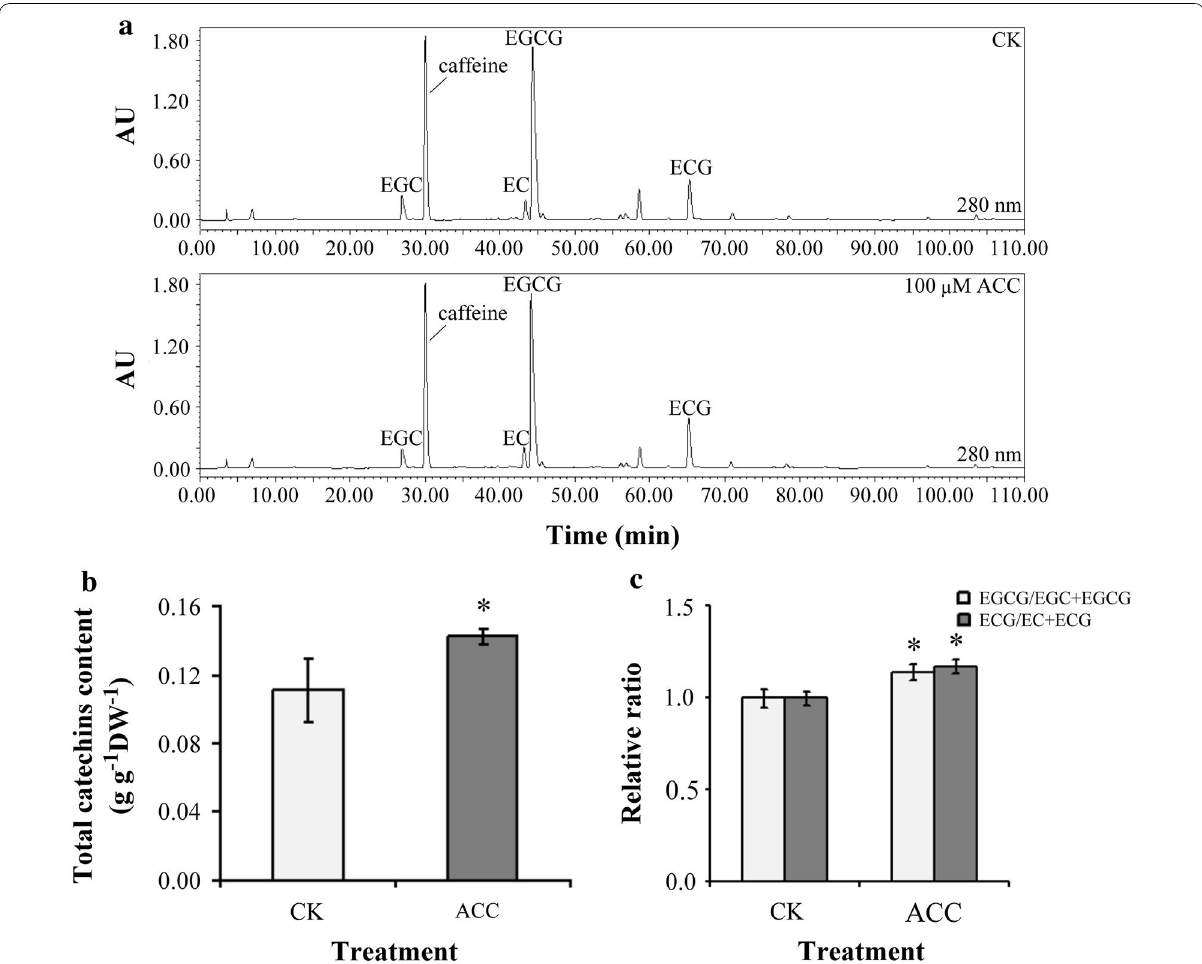
Fig. 1 Effects of ethylene signaling on the content and degree of catechin galloylation in tea seedlings. a Caffeine and the four major catechins, EC, EGC, ECG, and EGCG, were detected. b Total catechin content. c The relative ratio was calculated as follows: ECG/(EC (EGC EGCG). Data points are mean SD of five biologically independent experiments. Asterisks indicate significant differences from the control + ± sample (P < 0.05; Student’s t